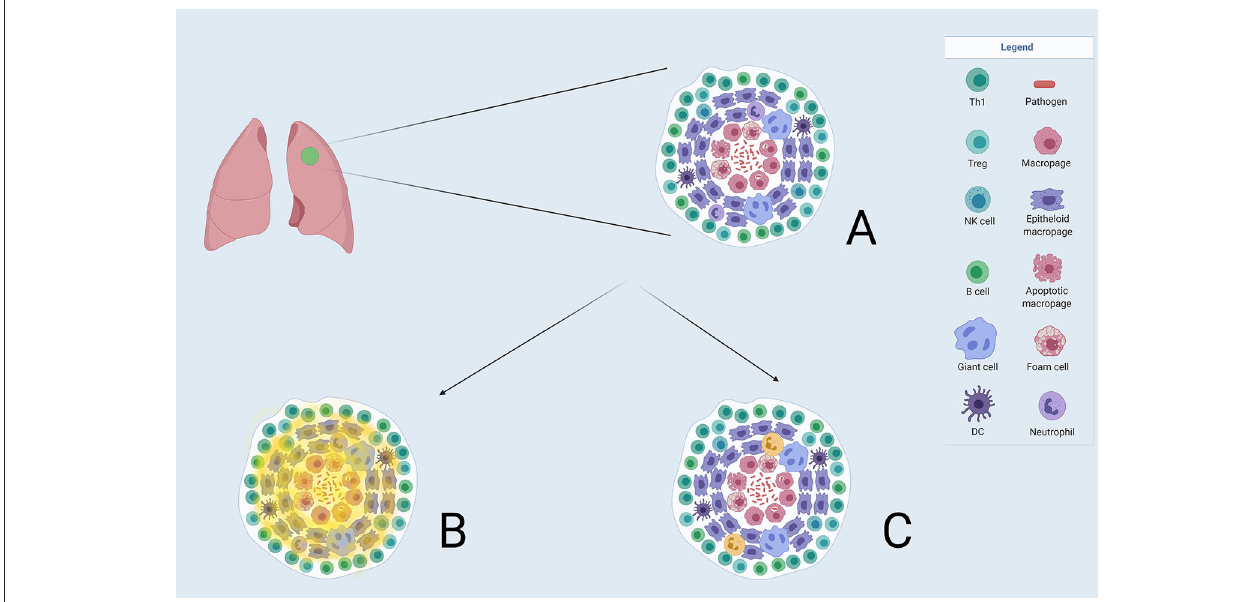
FIGURE 3 | (A) A TB granuloma with the constellation of different cell types. Macrophages are seen at the centre which can be differentiated into other cell types illustrated. Neutrophils form part of the granuloma. (B) Demonstrates where the 2-[ 18 F]FDG uptake(in faint yellow) is distributed in a granuloma, and not being able to discriminate between the relevant cell types. (C) Shows the projected uptake of FPR1-mediated molecular imaging (in bold yellow) with Gallium-68-nanotracer-cFLFLF highlighting neutrophils in the